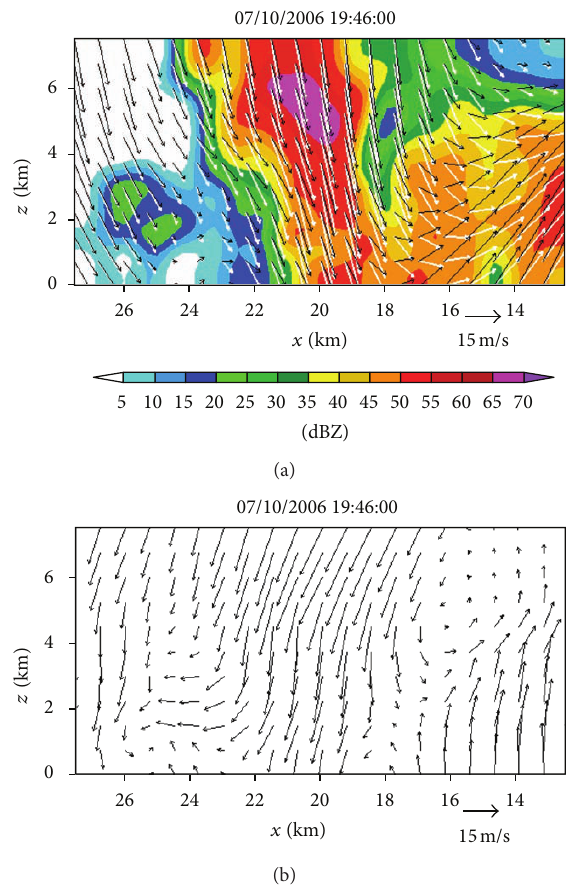
Figure 11: (a) As in Figure 6(c) but the retrieved (𝑢 𝑚2 , 𝑤 𝑎 𝑚 ) field is from the second step of Expt-5min (around 19 :46 :00 UTC). (b) The difference field obtained by subtracting the (𝑢 𝑚2 , 𝑤 𝑎 𝑚 ) field in Figure 6(c) from that in